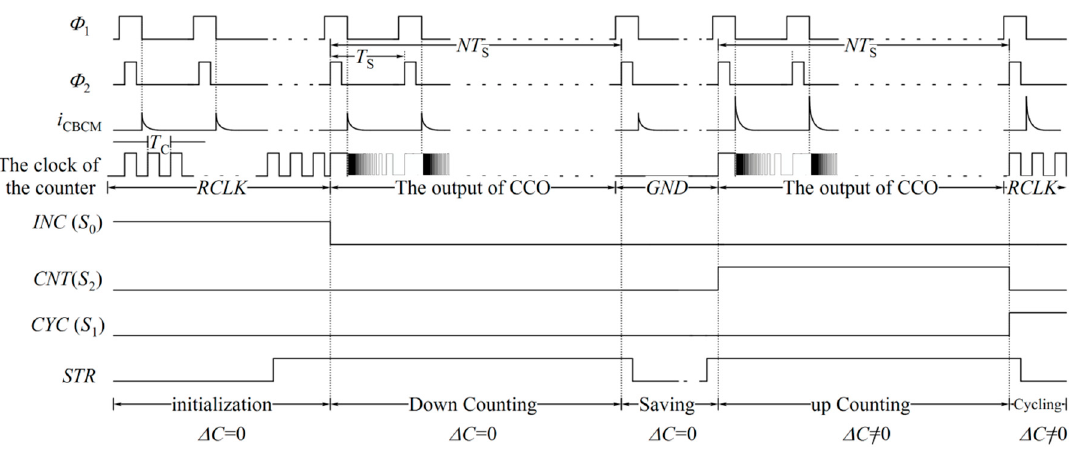
Figure 14. Different waveforms of the proposed sensor.